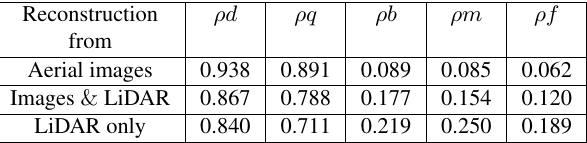
Table 6: 2D quality